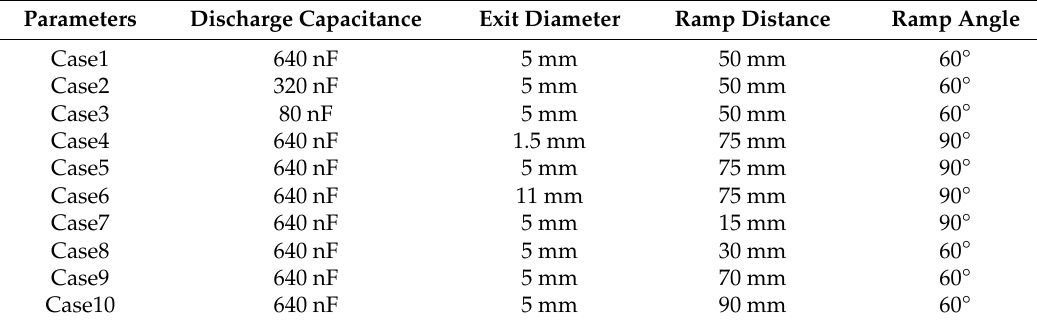
Table 2. Experimental cases